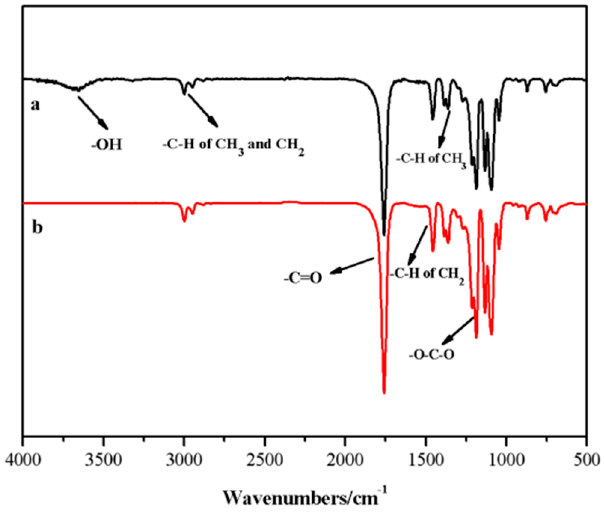
Figure 1. Fourier-transform infrared (FTIR) spectra of ( a ) OH-PLLA-SS-PLLA-OH (SP) and ( b ) iBuBr-PLLA-SS-PLLA-iBuBr (SPBr).